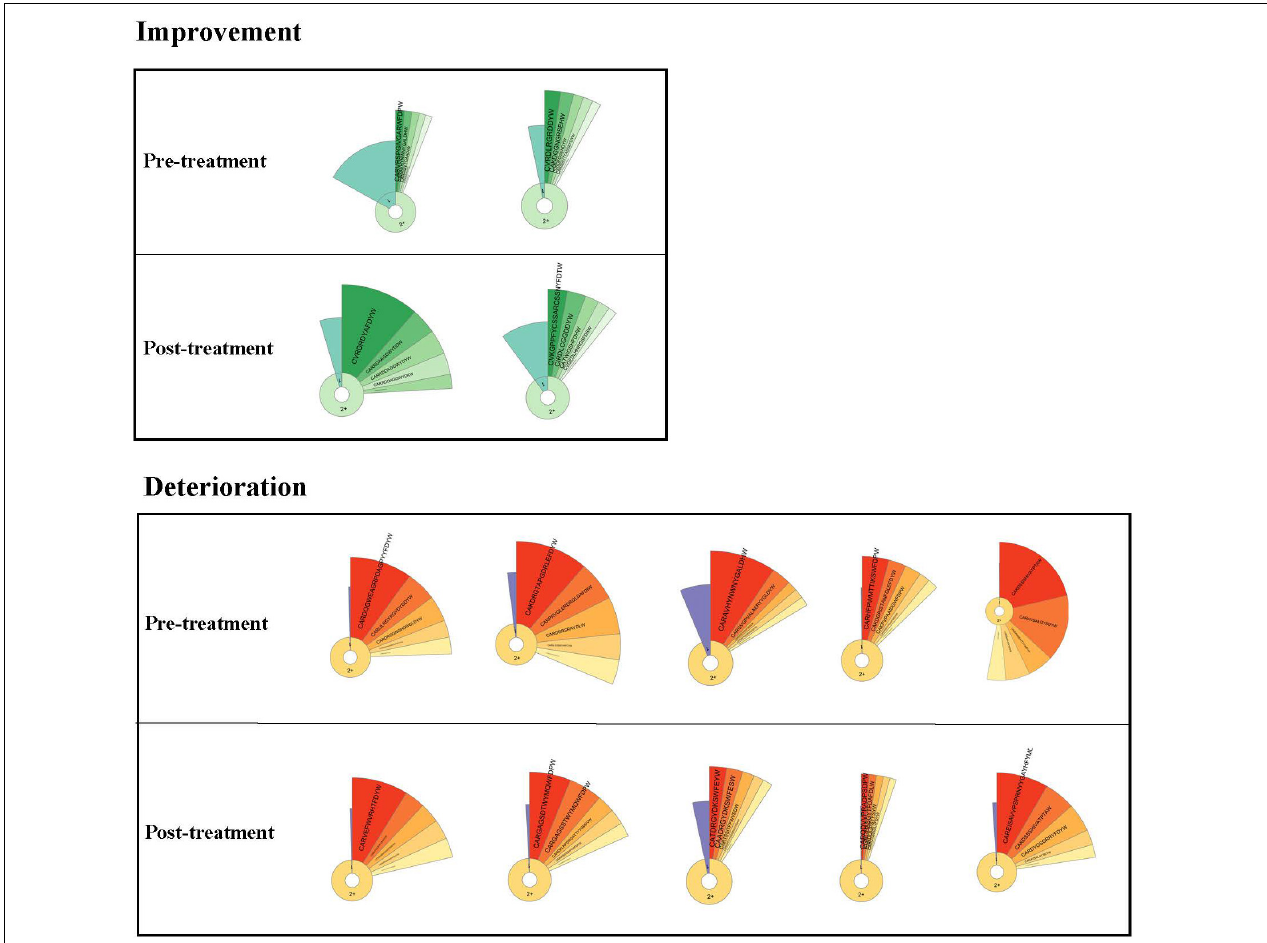
FIGURE 5 | Donut charts of IGH. The donut charts of seven patients for post- and pretreatment. The fan-shaped area depicts the corresponding clonal frequency. The area of “1” in the donut chart represents the frequency of singletons. “2+ ” area represents the sequences whose reads were two or more than two. A larger radian means a higher clonal frequency. The top five clones’ amino acid sequences of complementarity-determining region 3 (CDR3) of IGH are